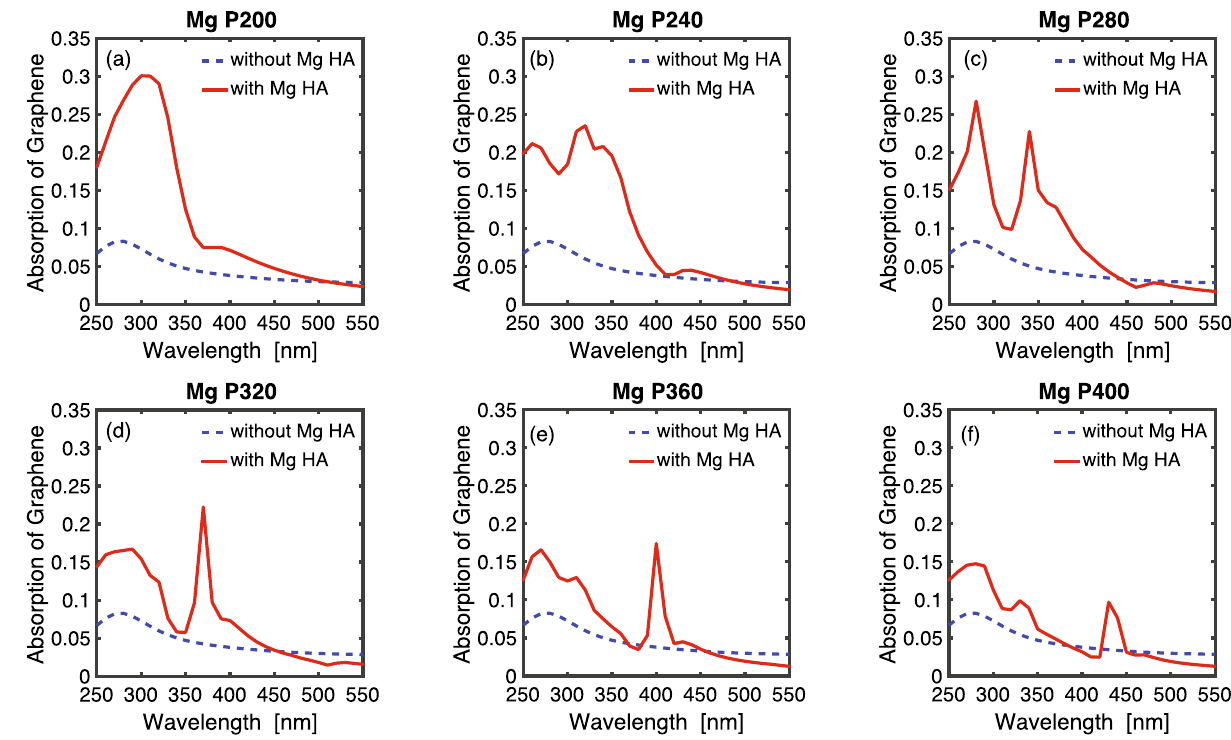
Figure 5. Graphene absorption spectrum on a magnesium hole-array. The periodicities of the magnesium hole- array are ( a ) 200 nm ( b ) 240 nm ( c ) 280 nm ( d ) 320 nm ( e ) 360 nm ( f ) 400 nm. The solid red line represents the absorption in graphene on a magnesium hole-array. The dashed blue line represents the absorption in an intrinsic monolayer graphene without hole-arrays.